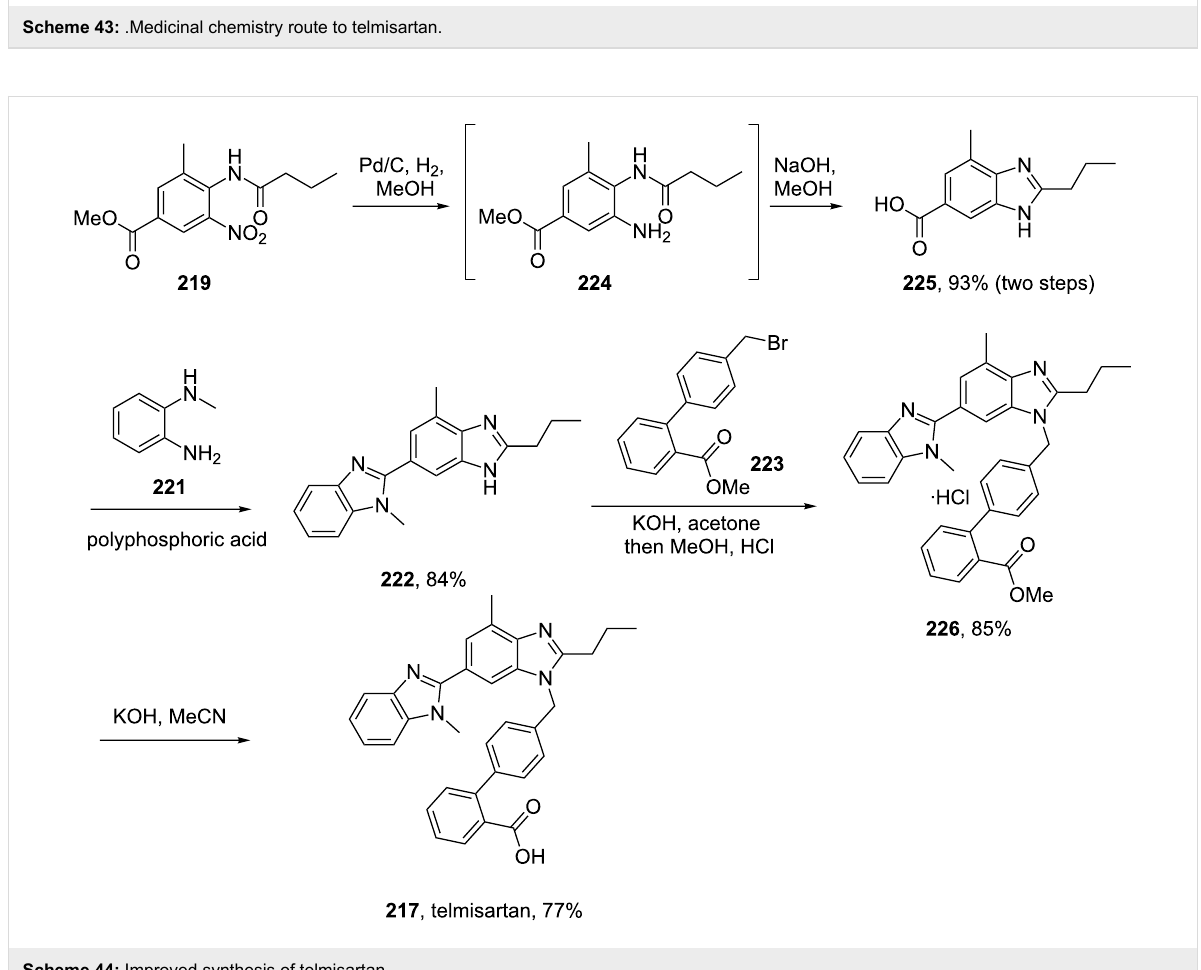
Scheme 44: Improved synthesis of